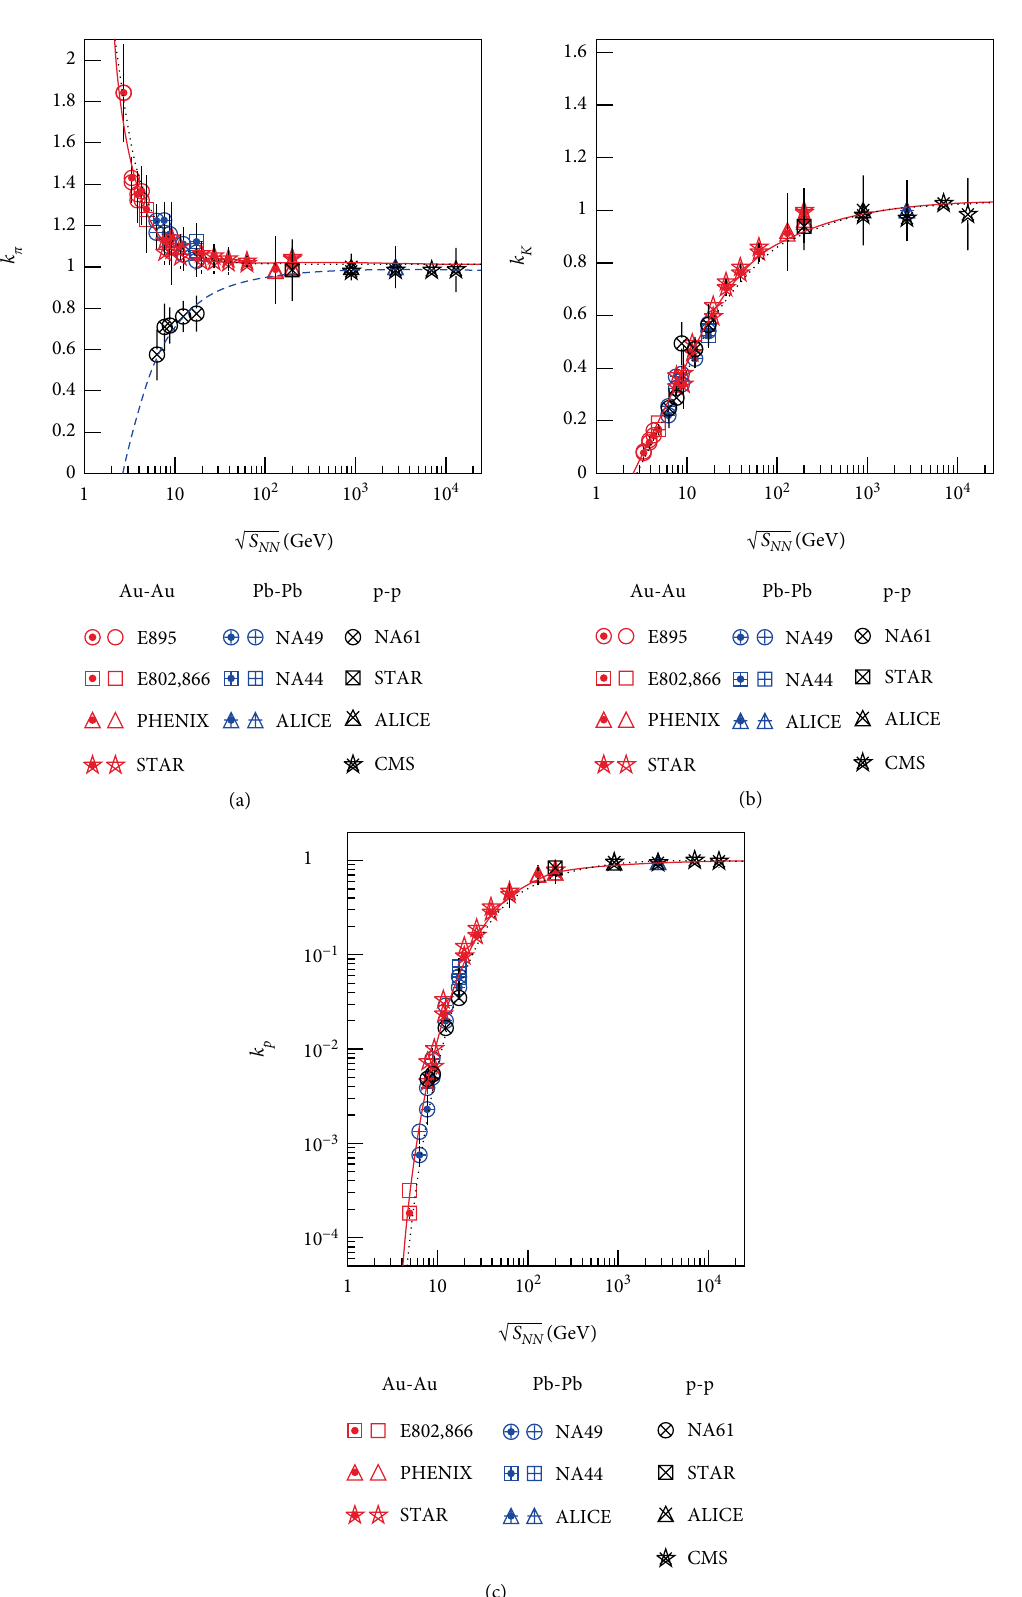
Figure 1: Yield ratios, (a) central Au-Au collisions, central Pb-Pb collisions, and INEL or NSD The circles, squares, triangles, and stars without 1 for details). The circles, squares, triangles, and stars with production by removing the contributions of strong decay from high-mass resonance and weak decay from heavy flavor hadrons [8]. The curves are the results fitted by us for the